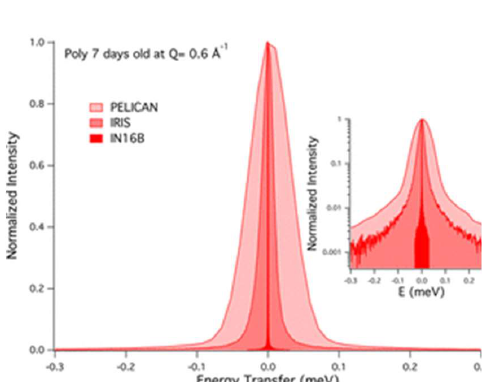
Fig. 9 . Dynamics of aqueous polyacrylic acid in dental restorative cements: QENS spectra collected at backscattering and time-of-flight spectrometers. Reprinted with permission from [27]. Copyright 2018 American Chemical Society.